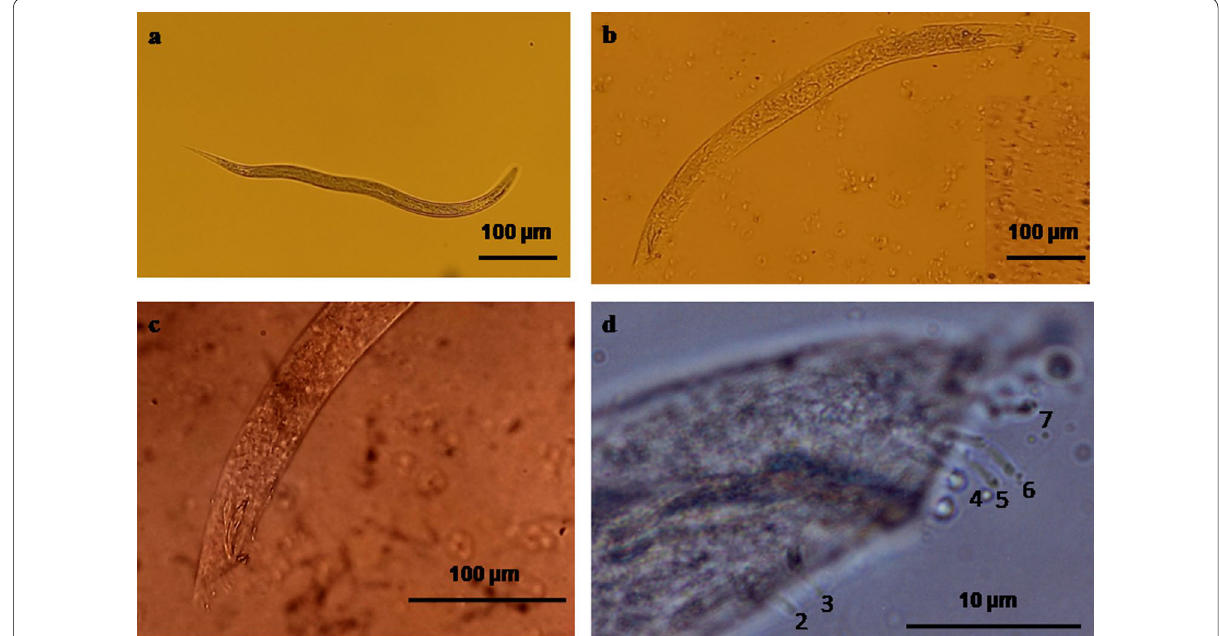
standard deviation (range) ( N ±